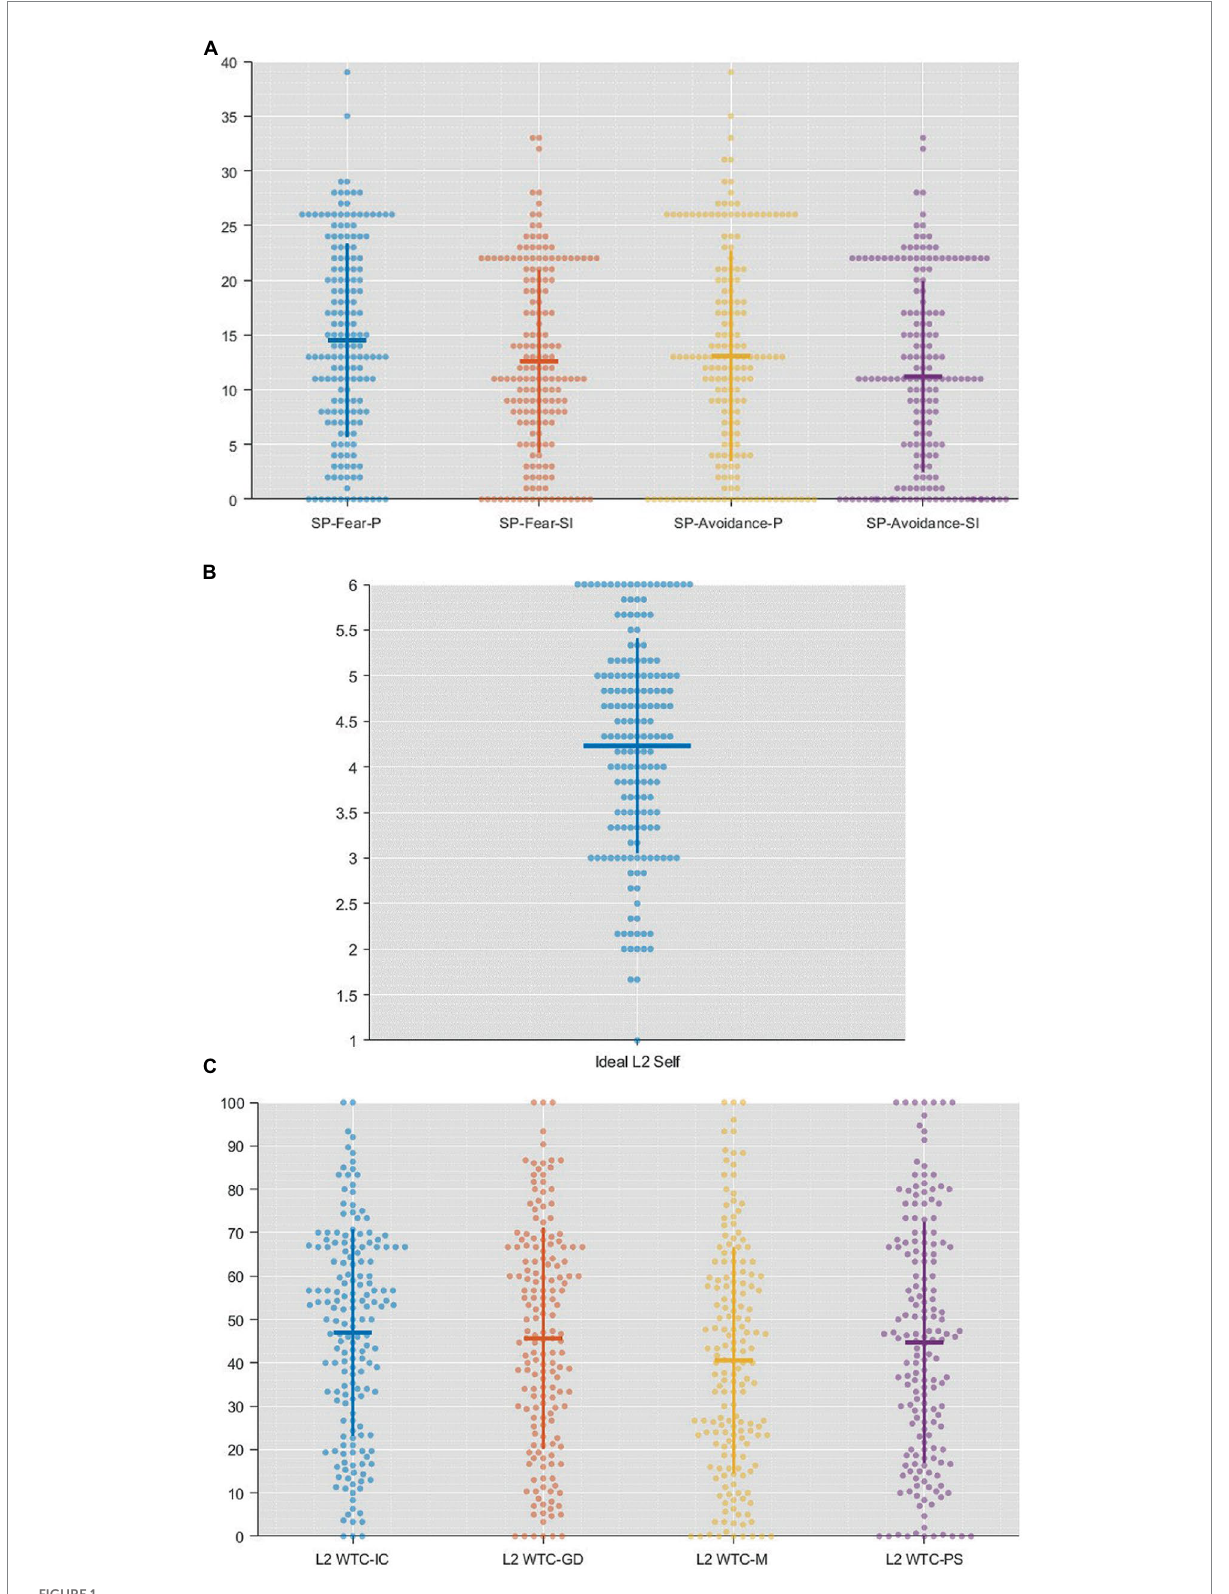
FIGURE 1 (A) Beeswarm plot – Social phobia. SP: Social phobia; P: Performance; SI: Social interactions. (B) Beeswarm plot – Ideal L2 self. (C) Beeswarm plot – L2 WTC. IC: Interpersonal conversations; GD: Group discussion; M: Meetings; PS: Public